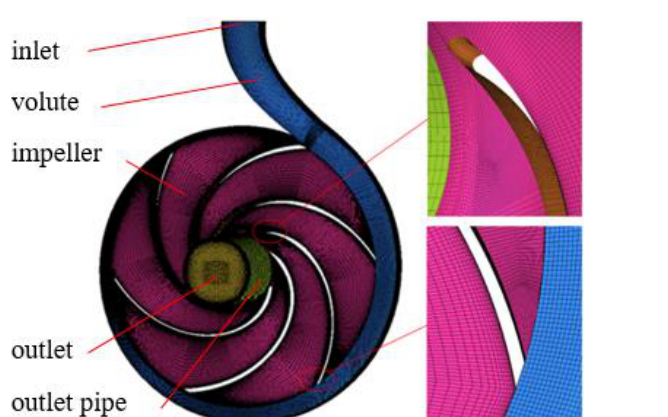
Figure 1. Structure of PAT.